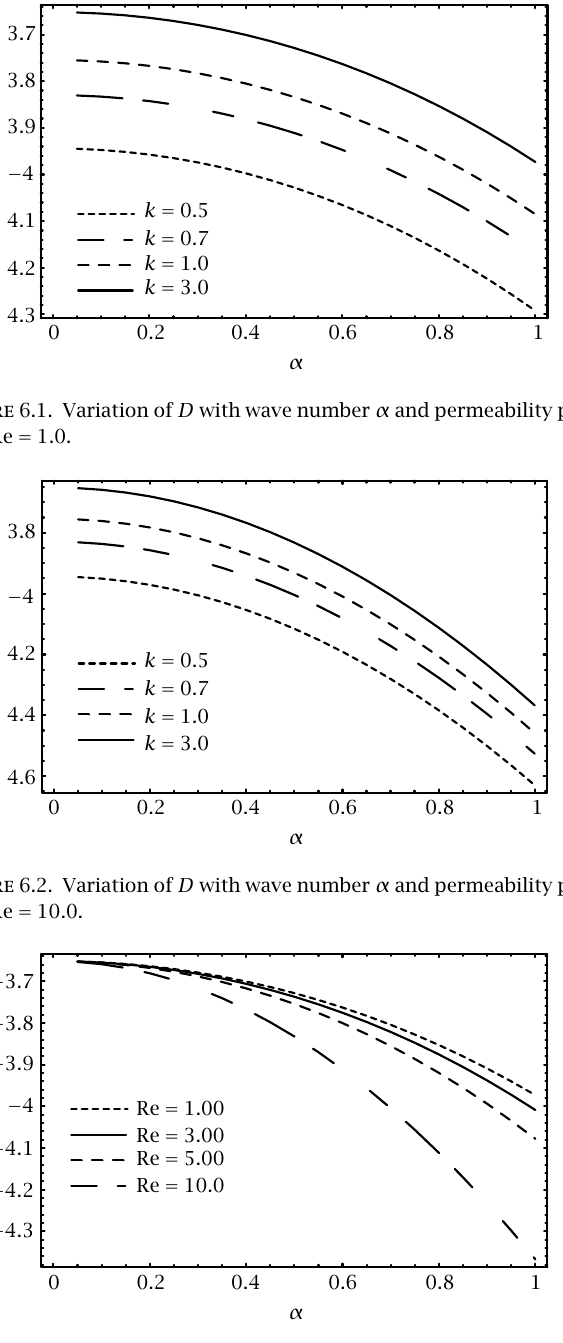
Figure 6.3 . Variation of D with wave number α and Reynolds number Re at k = 0 .